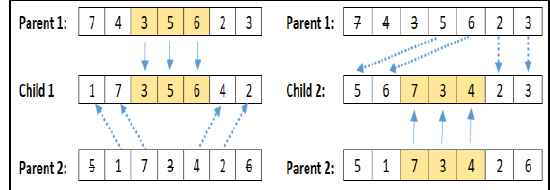
Fig4. The process of Order Crossover